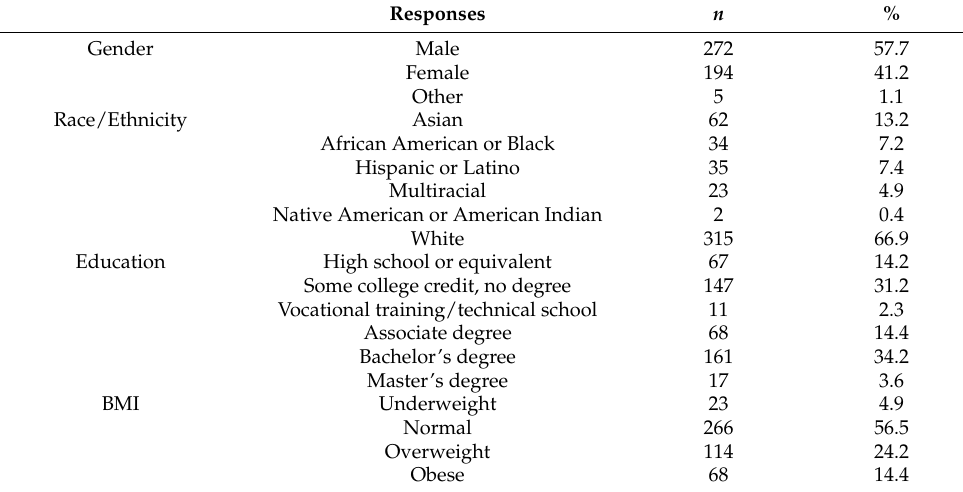
Table 2. Sample demographics ( n = 471).